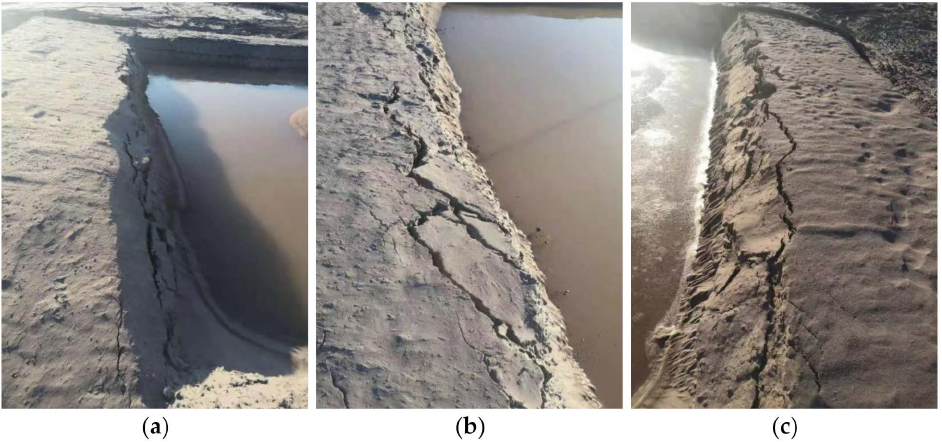
Figure 7. Failure details of each test dam after 18 h of data collection: ( a ) geogrid-reinforced dam, ( b ) conventional dam, and ( c ) geotextile-reinforced